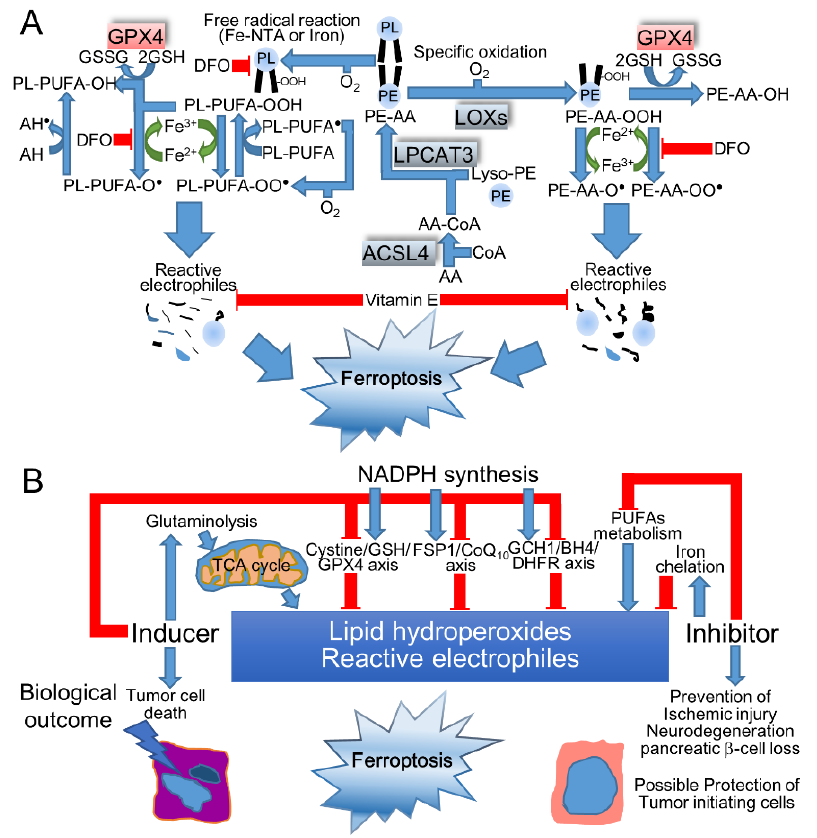
Figure 4. Ferroptotic signaling pathway. ( A ) Among phospholipids (PLs), PE-esterified AA or AdA are predominantly located in the inner leaflet of the plasma membrane or nonbilayer arrangements in contrast to the high PC confinement on the outer membrane or ordered bilayer organization of